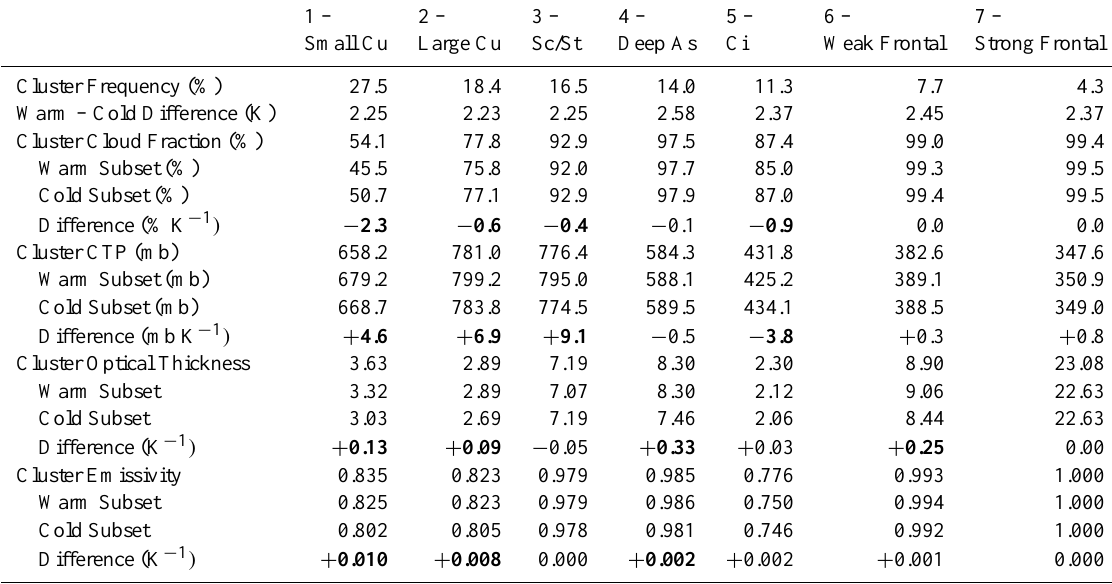
Table 4. Average cloud properties for the entire cluster, warm subset, cold subset, and the difference between the two divided by the temperature change for each cluster (Subsets different at the 95% confidence level are in bold).